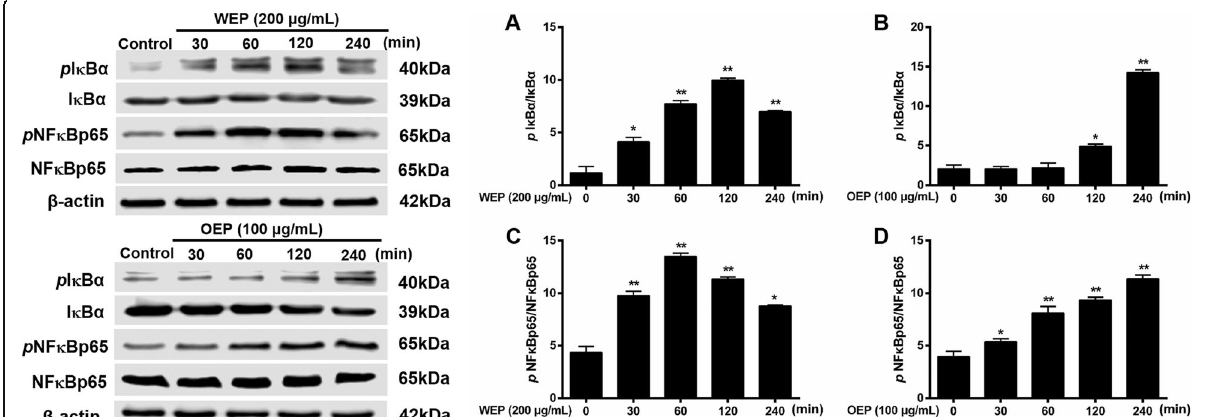
Fig. 6 NF- κ B pathway activation in RAW264.7 cells after exposure to PM 2.5 extracts. Protein synthesis in RAW264.7 cells exposed to 200 μ g/mL